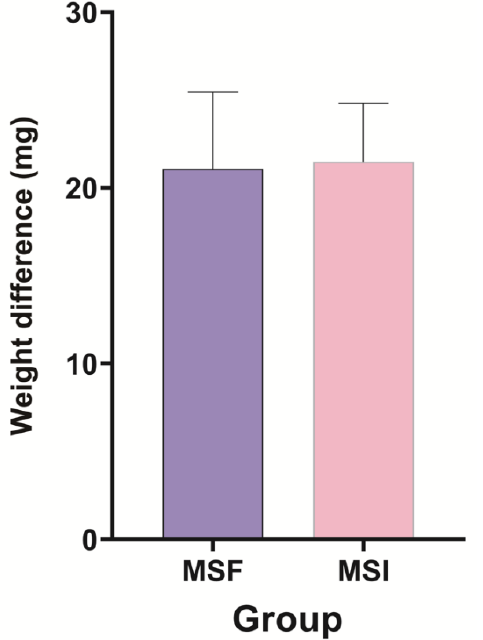
Figure 4. Preoperative and postoperative weight differences of the MSF and MSI groups. No statistically significant differences were observed. Data are expressed as mean ± standard deviations. Table 1. Weight difference of the surgical guides prior to and following implant placement and angular deviations prior to and following implant placement between the MSF and MSI groups.